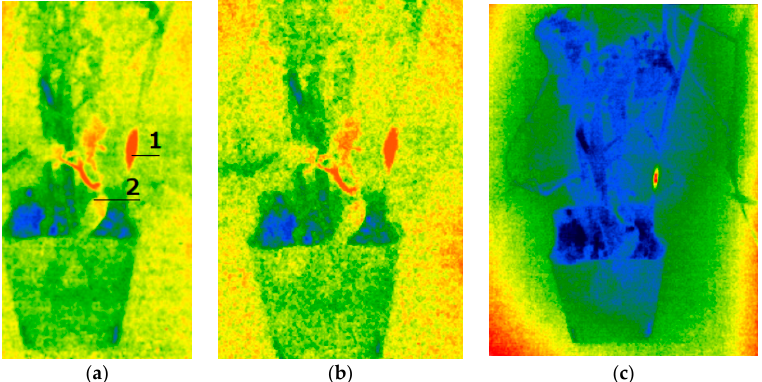
Figure 17. Infrared images of the result of a divided laser beam. The three images were taken with 10-s intervals. ( a ) This image was taken immediately after the treatment. 1. The spot where the straw of the E. repens was hit. 2. The damage tomato plant: ( b ) image taken 10 s after the first image; ( c ) image taken 20 s after the first image.